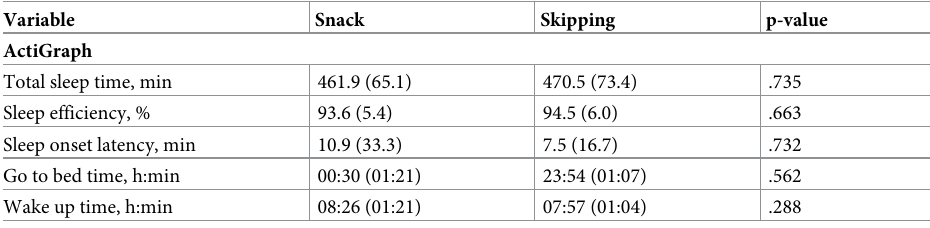
Table 1. Sleep sensitivity parameters by meal